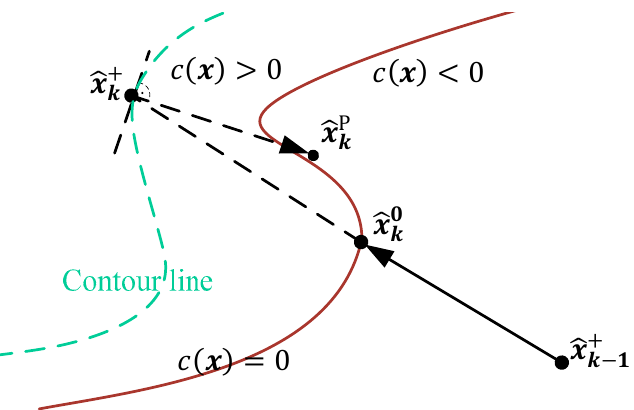
Figure A1. Principle of the Newton descent search for state constraint handling.